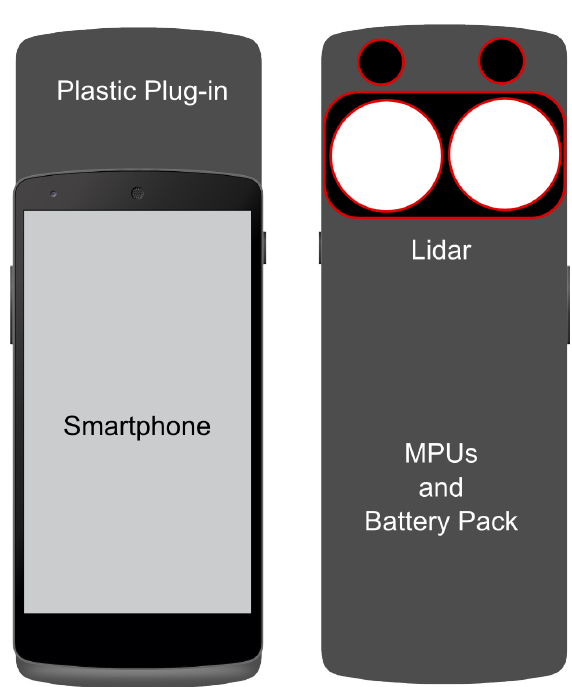
Figure 3: Device prototype scheme in which we show the smart- phone with its extension: the two color cameras, the Micro- LIDAR, the MPUs and the supplementary